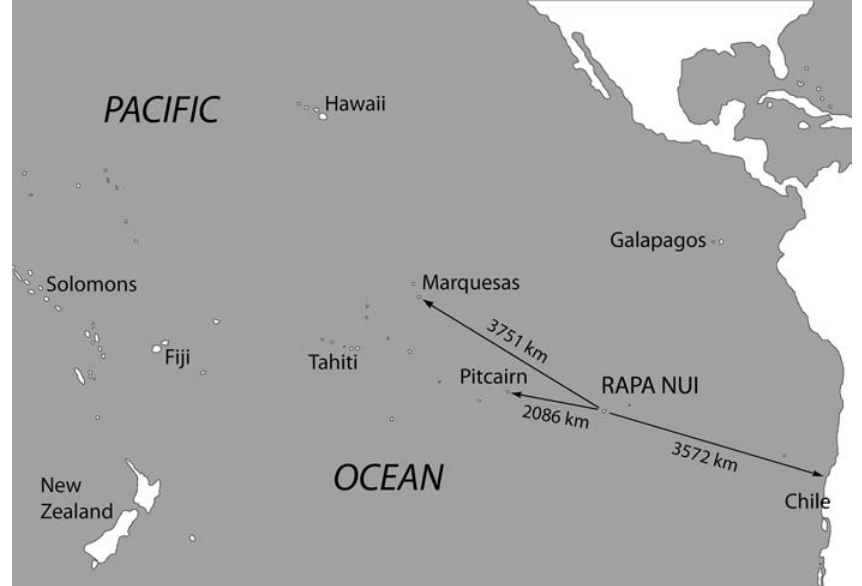
Figure 1 Easter Island (Rapa Nui) location map.